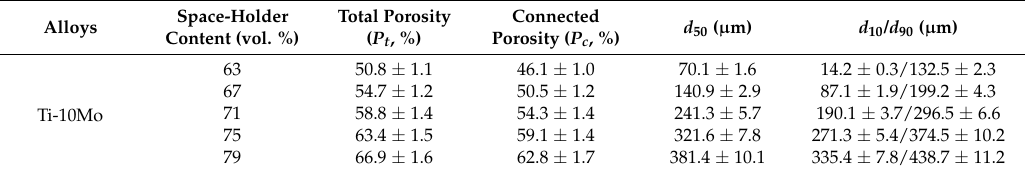
Figure 3. Distribution of pore size of samples with different content of NH 4 HCO 3 added: ( a ) 63%; ( b ) 67%; ( c ) 71%; ( d ) 75%; ( e ) 79%. Table 2. Pore characteristics of Ti-10Mo alloy with different content NH 4 HCO 3 added.